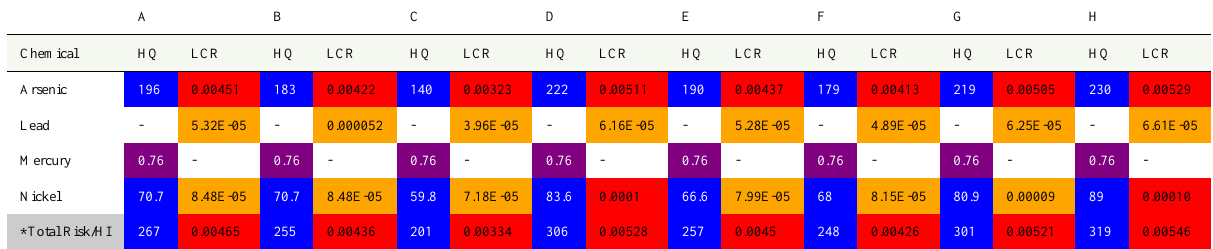
Table 11. LCR and HQ of heavy metals